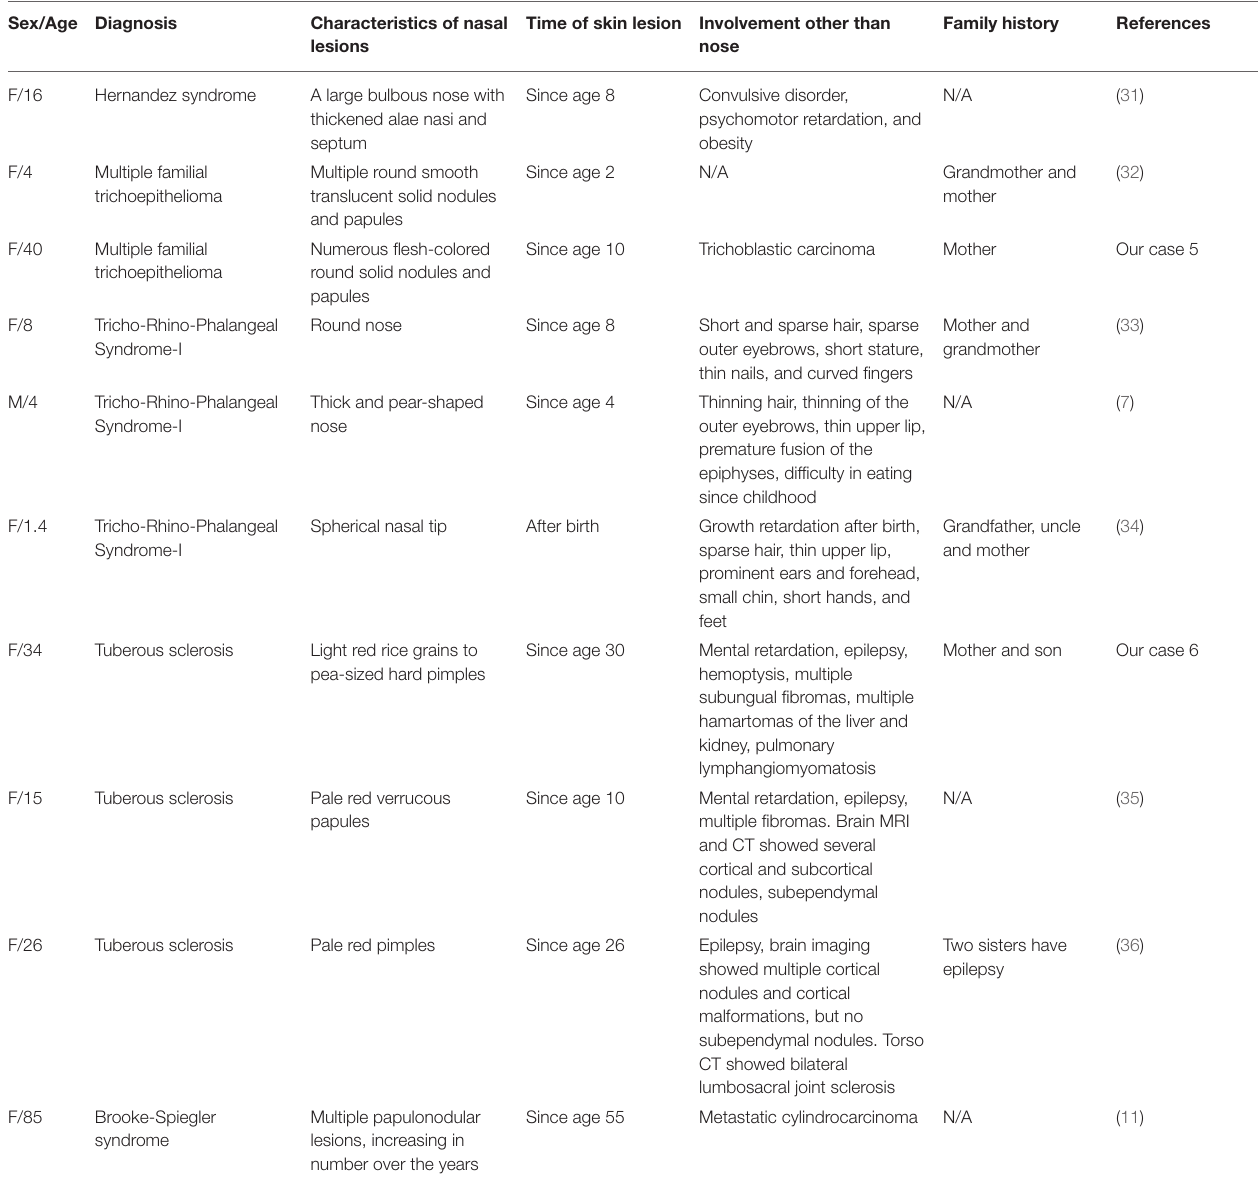
TABLE 3 | Clown nose-like lesion as a manifestation of genetic